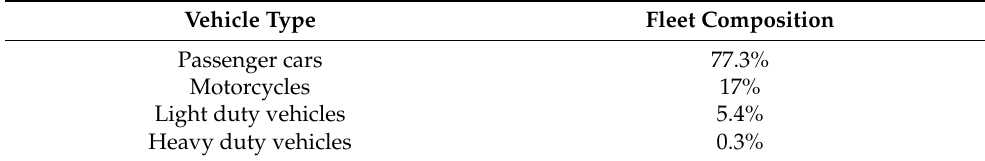
Table 2. Fleet composition by vehicle type.